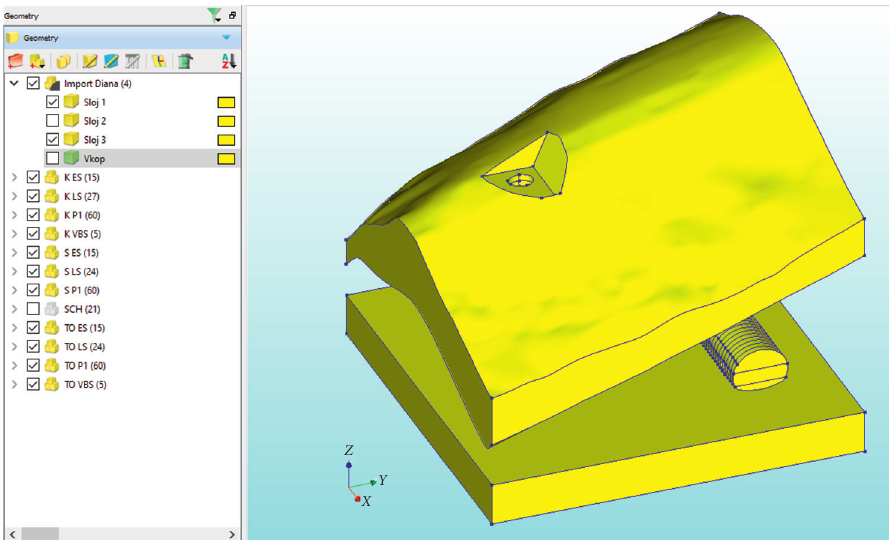
Figure 14: Geometry manipulations in DIANA FEA.